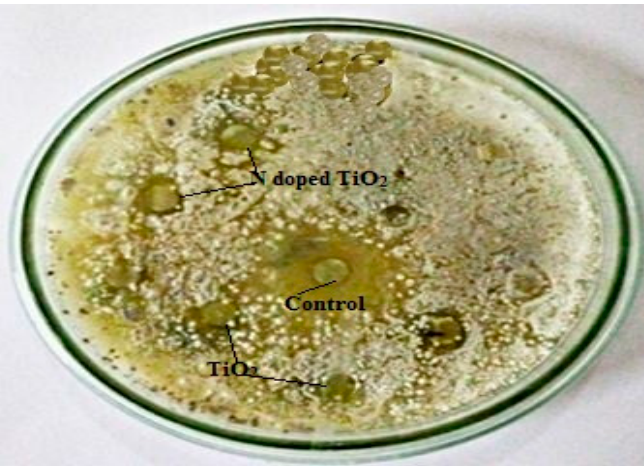
Figure 12. Protein kinase inhibition exhibited by TiO 2 nanoparticles and N-doped TiO 2 nanoparticles. Error bars are shown as standard deviation on each bar. Bars are significantly different at confidence interval level of 95%.